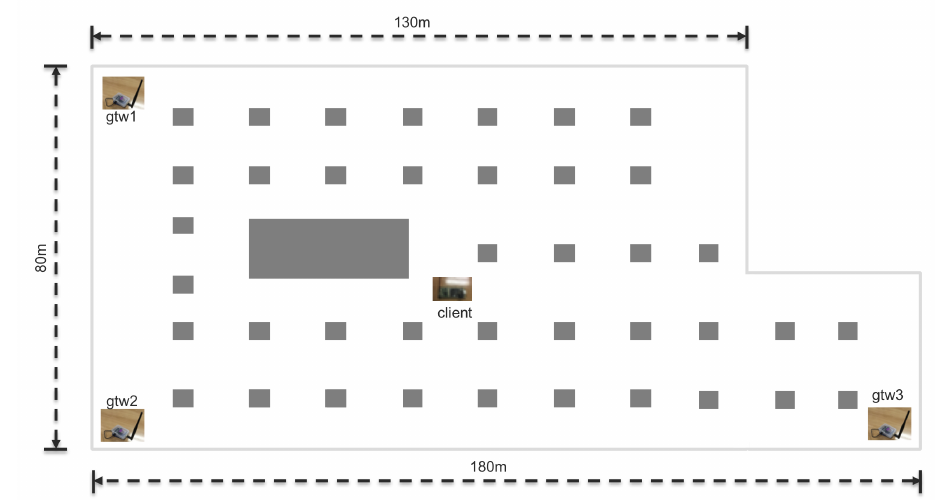
Figure 6. The map of the localisation experiments with the position of the gateways and of the